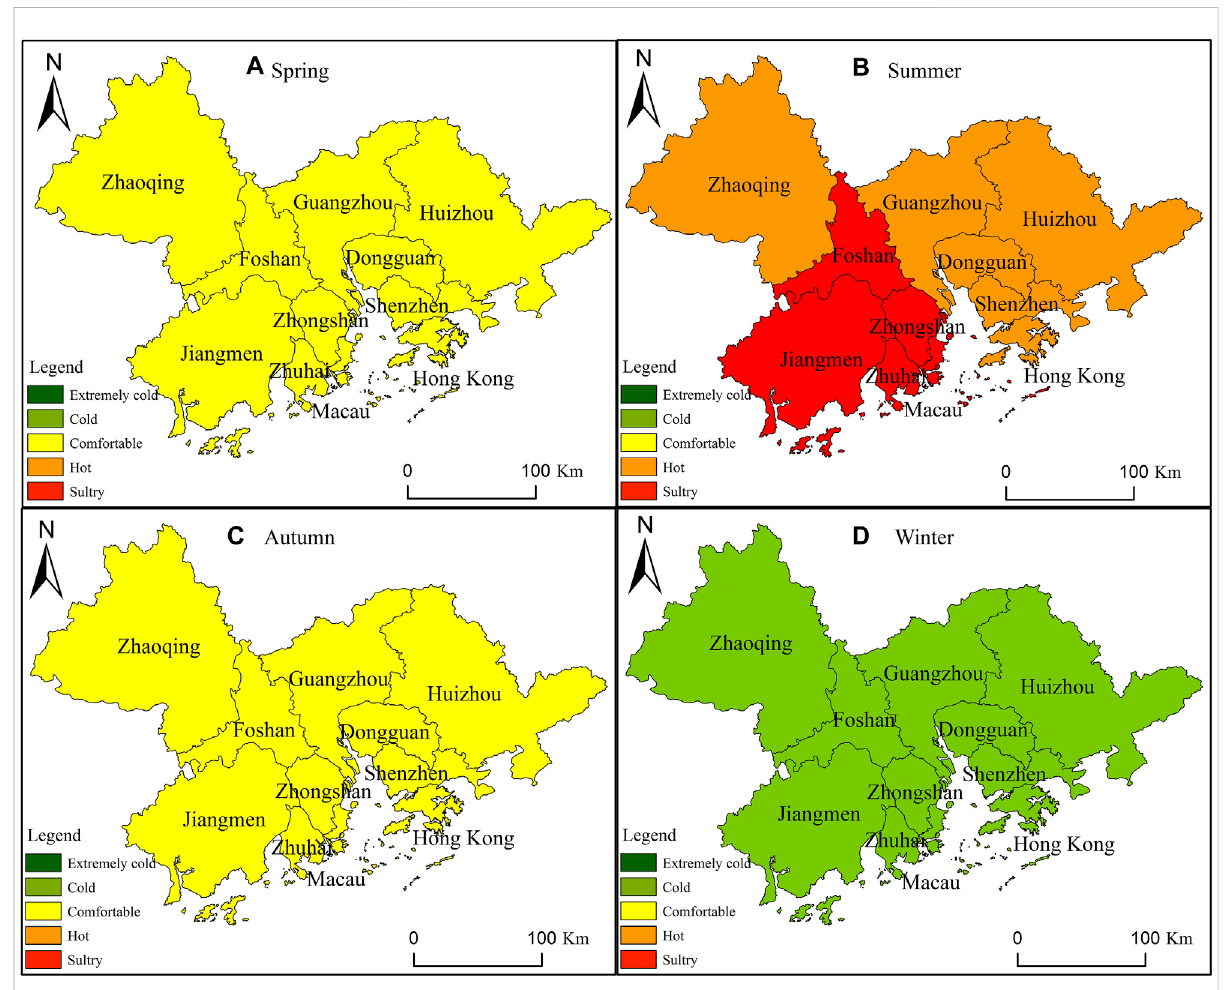
FIGURE 9 Seasonal change of climate comfort of human settlements in the Guangdong – Hong Kong – Macau Greater Bay Area in